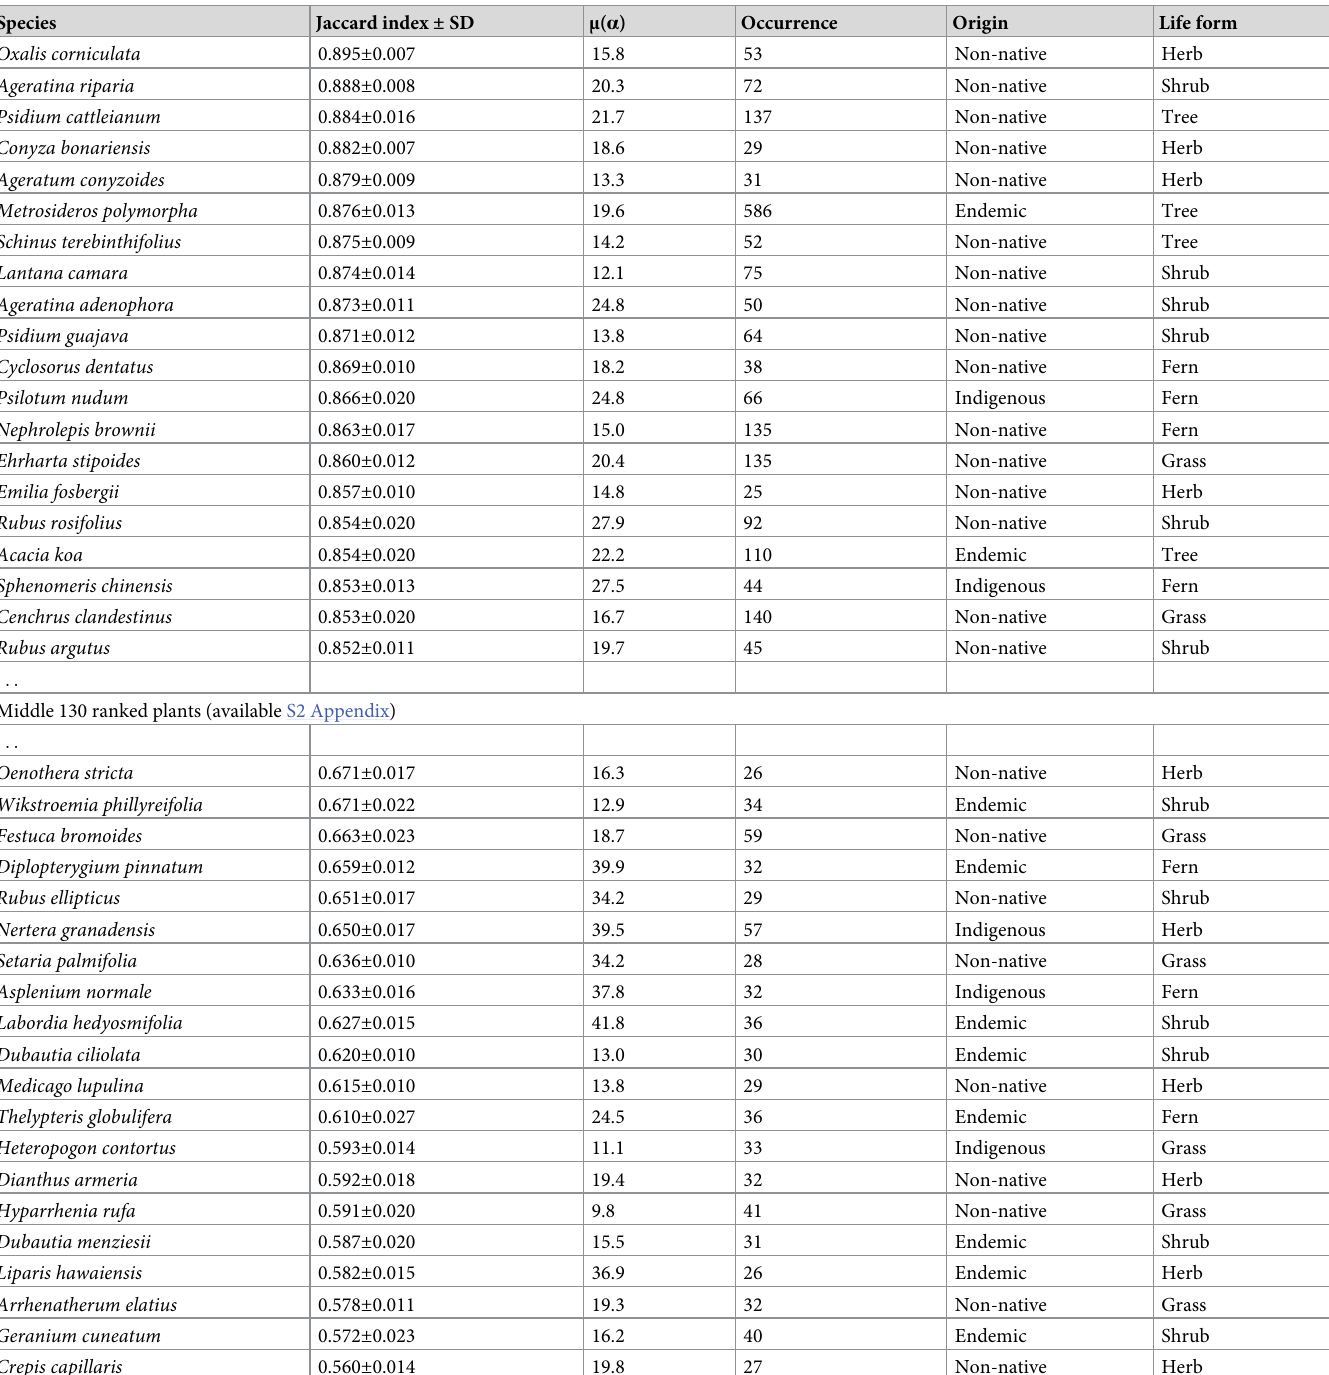
Table 3. The twenty most generalist and most specialist plant species (highest and lowest Jaccard index values, respectively). The entire 170 plant species rank order and details are available in S2 Appendix. For each species, the Jaccard index value (standard deviation (SD) based on 100 permutations of selecting 25 plots), mean alpha richness per plot listed as μ ( α ), total number of plot occurrences out of 1019 possible, species origin, and life form are provided. Species